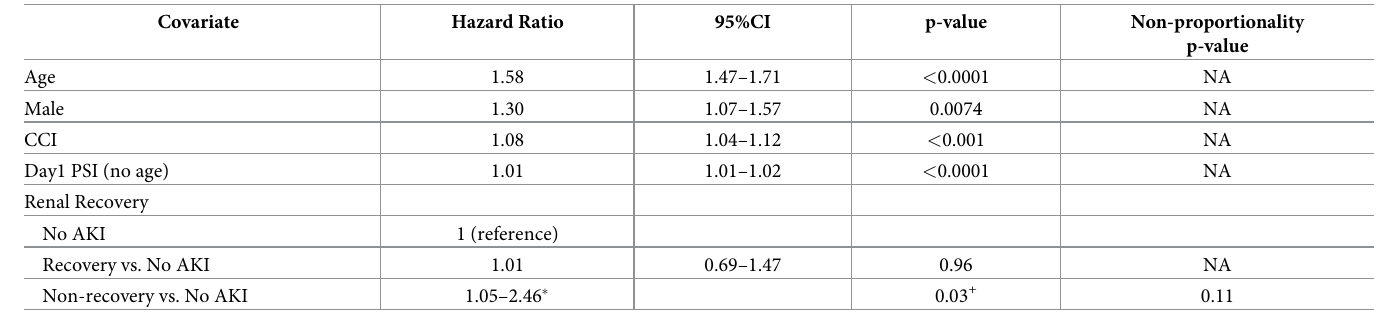
Table 3. Factors associated with increased 3-year mortality (n =